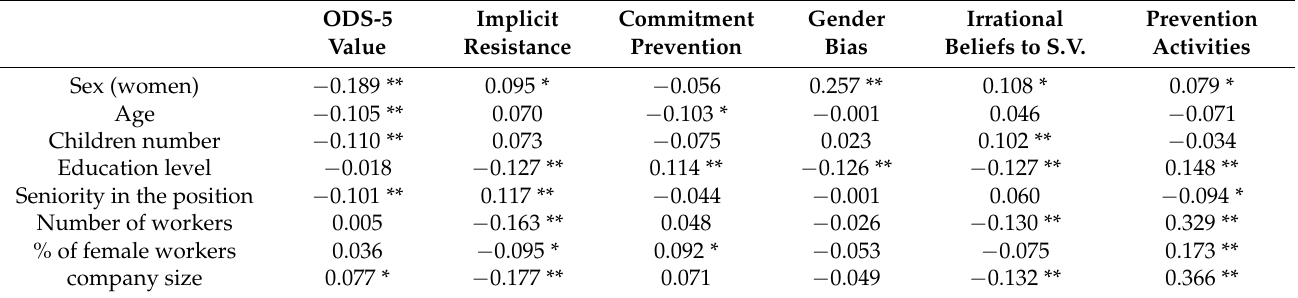
Table 2. Correlations between labor and demographic variables with target variables.